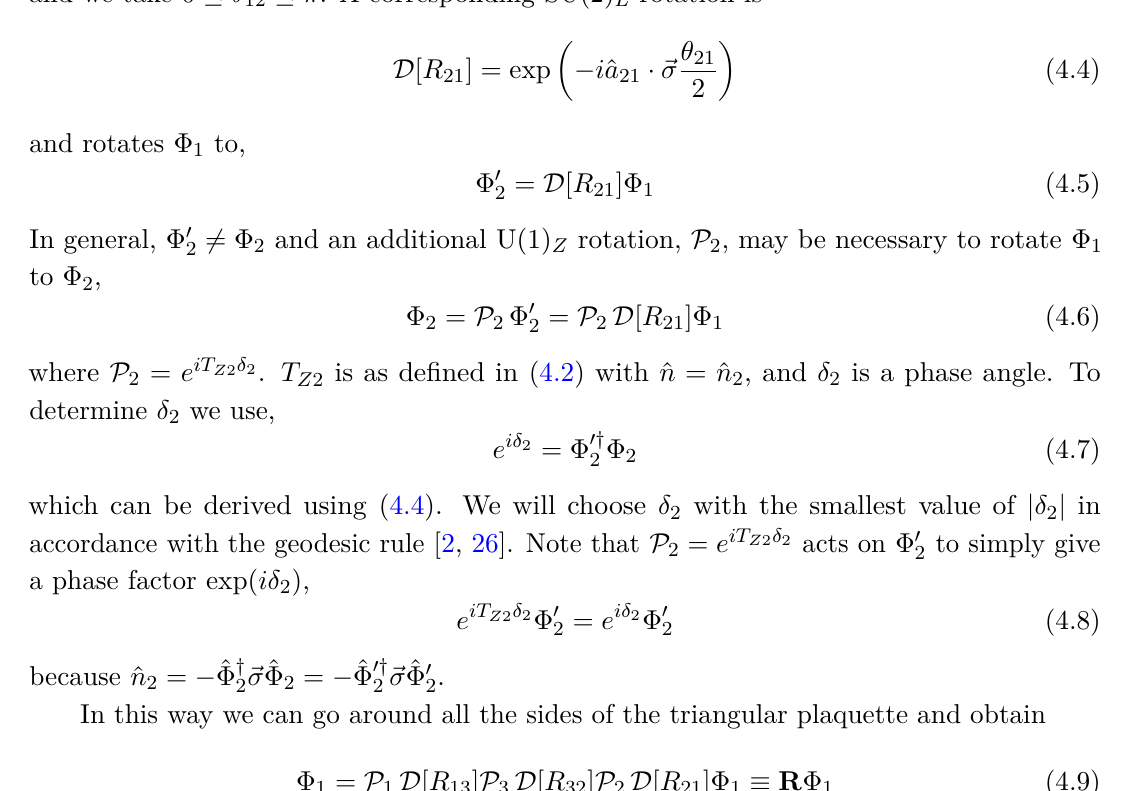
Figure 1 . A triangular plaquette is assigned values of Φ at its vertices, from which we determine corresponding values of ˆ n using (3.4). We find the rotation R 21 that takes ˆ n 1 to ˆ n 2 . This rotation in SO(3) also defines a rotation, D [ R 21 ] in SU(2) L that acts on Φ 1 to give Φ 0 from Φ 2 by rotation by an element P 2 ∈ U(1) Z , at vertex 2. Similarly we can obtain the rotations that take Φ 2 to Φ 3 , and Φ 3 to Φ 1 . The total rotation in going from vertex 1 around the triangle and back to vertex 1 is: P 1 D [ R 13 ] P 3 D [ R 32 ] P 2 D [ R 21 ] , and this rotation acts on Φ 1 to give back Φ 1 . If the net Z-phase rotation in going around the plaquette is ± 2 π , there is a Z-string (or anti-string) passing through the